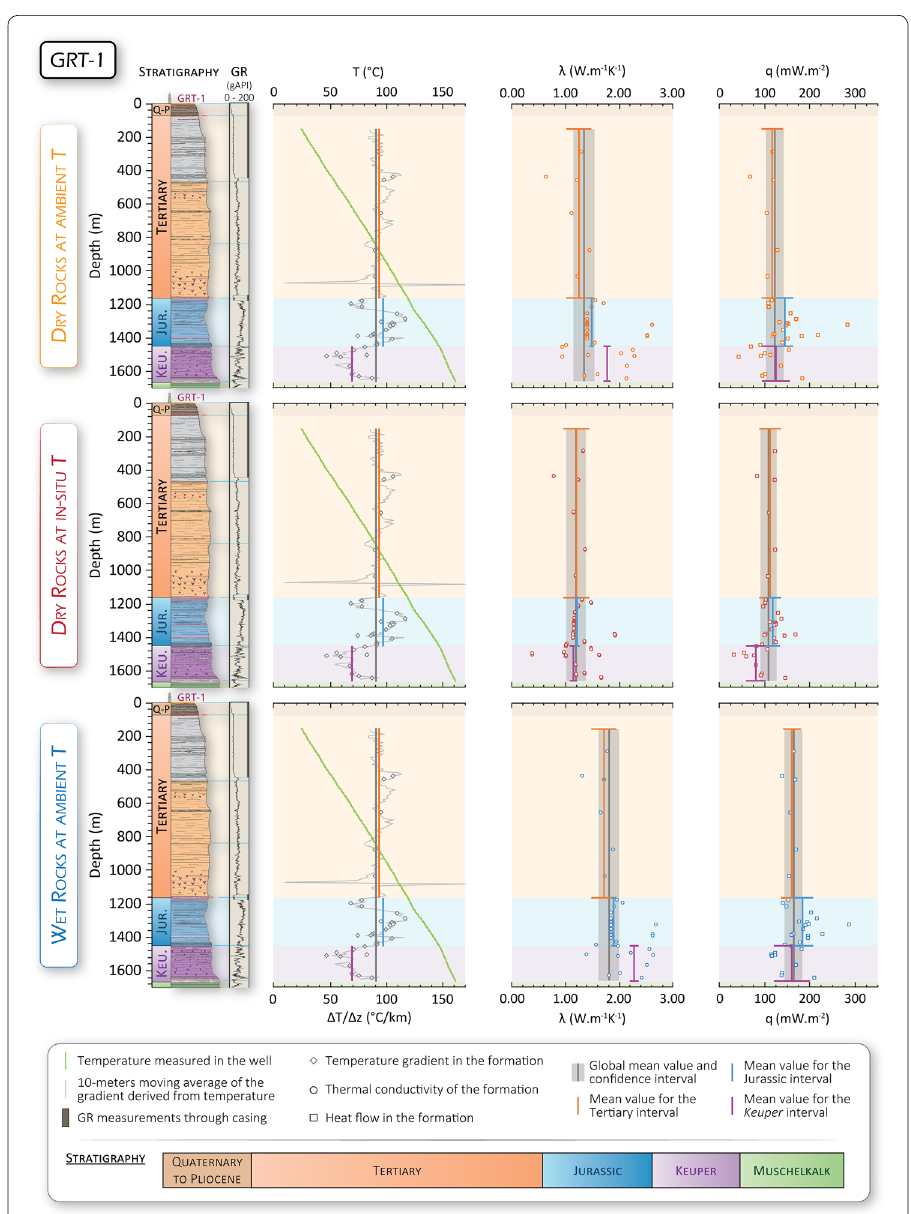
Fig. 12 Stratigraphic log and gamma ray (GR) (after Duringer et al. 2019), measured temperature profile T and derived temperature gradient ∆ T /∆ z (same scale as temperature profile), thermal conductivities λ for dry, hot and wet formations and associated calculated heat flow densities q for the Rittershoffen GRT-1 well. Vertical lines indicate mean values for ∆ T /∆ z (left), λ (middle) and q (right) for a given interval (global (from surface to top of the Muschelkalk ), Tertiary, Jurassic and Keuper ). Dots indicate average value for a given formation. Stratigraphy is shown in the background for each